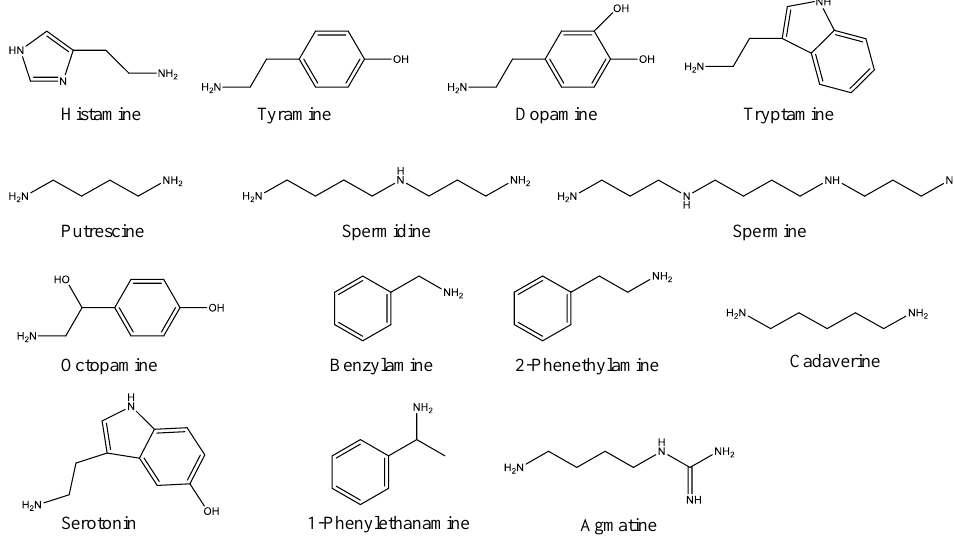
Figure 1. Chemical structures of the 14 BAs.